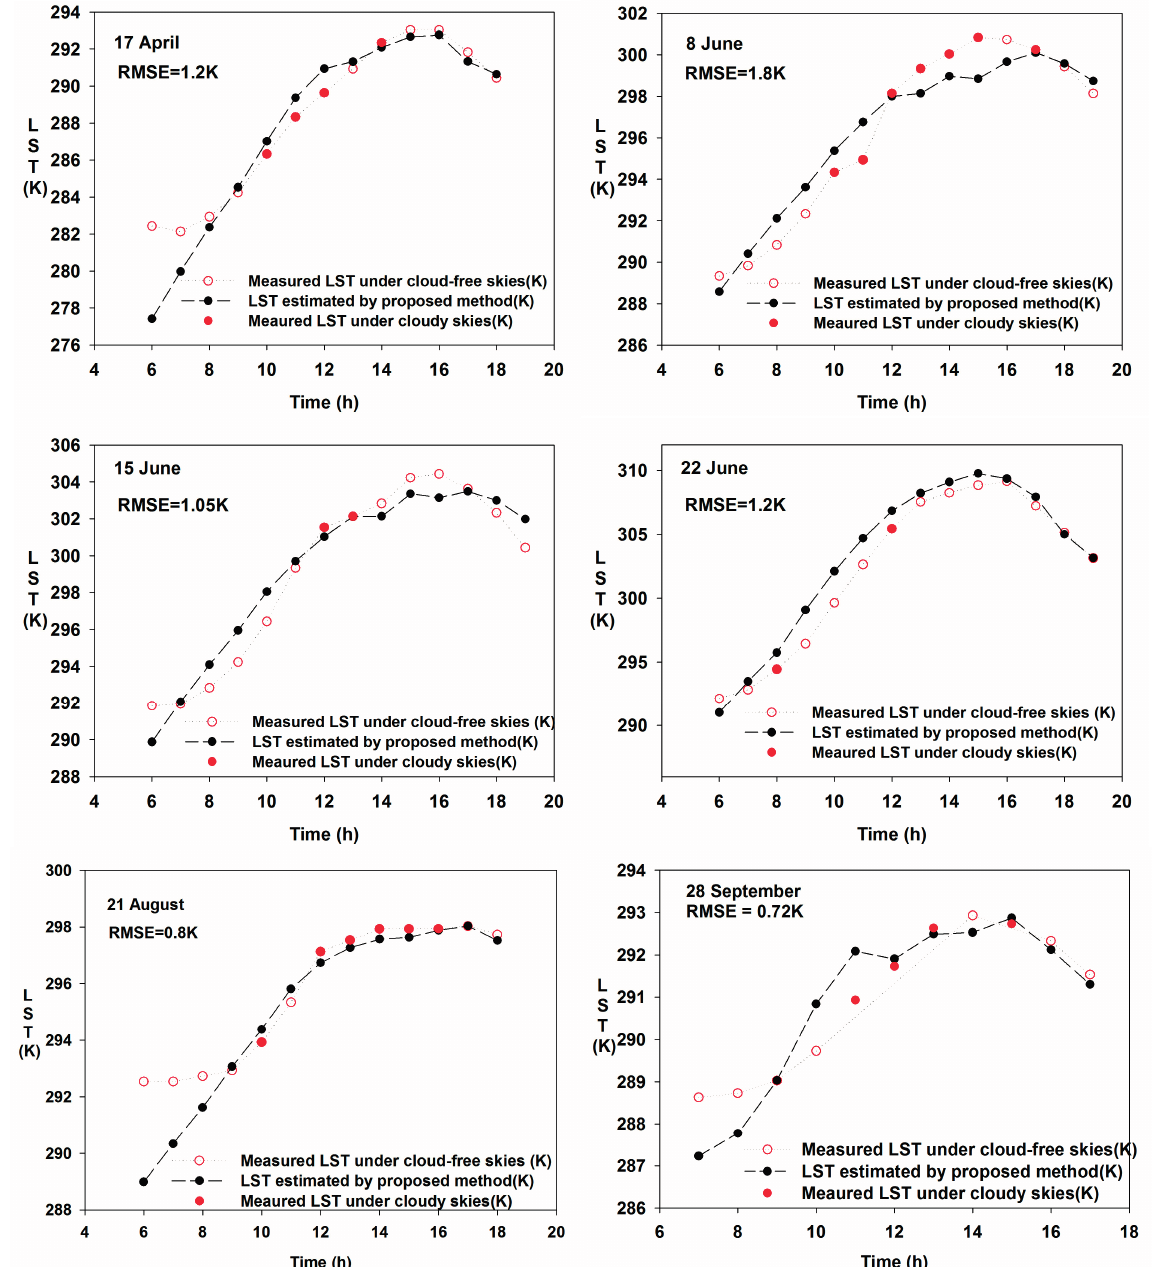
Figure 4. Comparison of the measured daily temperature evolution with that predicted by the proposed method for six days under various cloud